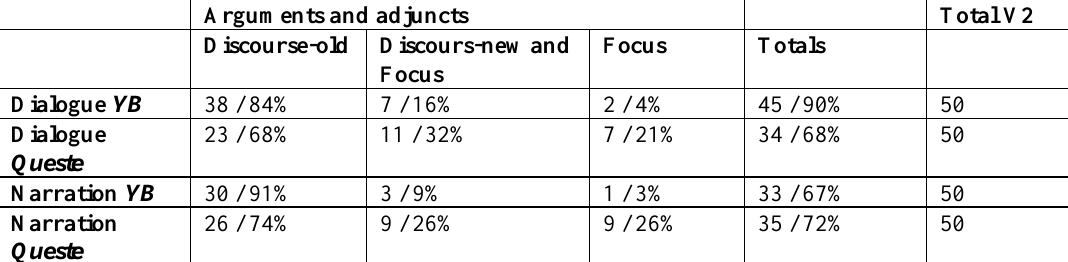
Table 5. Rates of informational values per language modality in two 13 th c. texts Arguments and adjuncts Total V2 Discourse-old Discours-new and Focus Focus